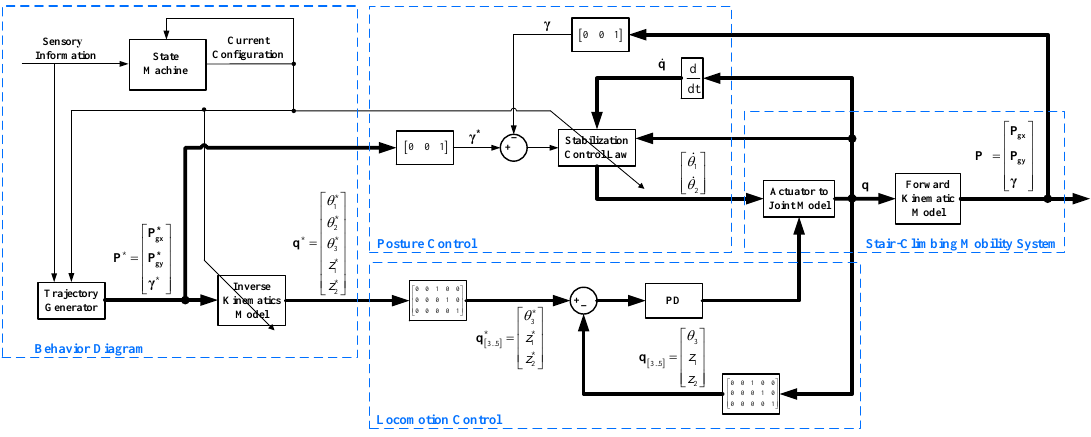
Figure 14. Control scheme of the proposed